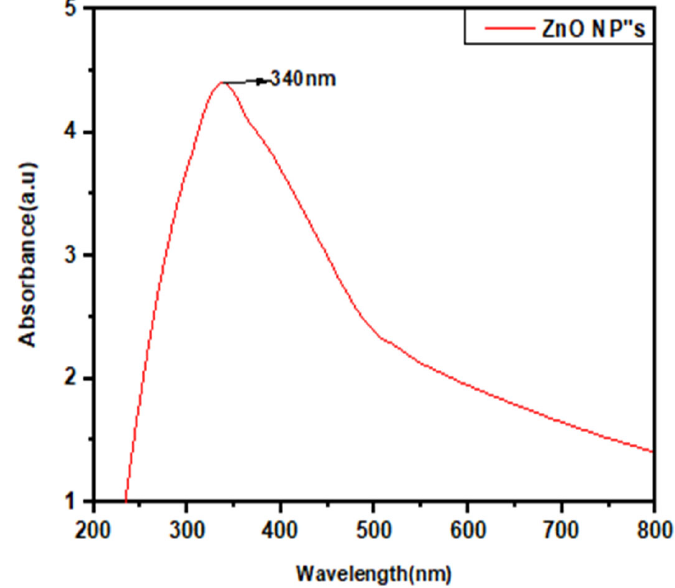
Figure 3. UV–visible spectrum of ZnO